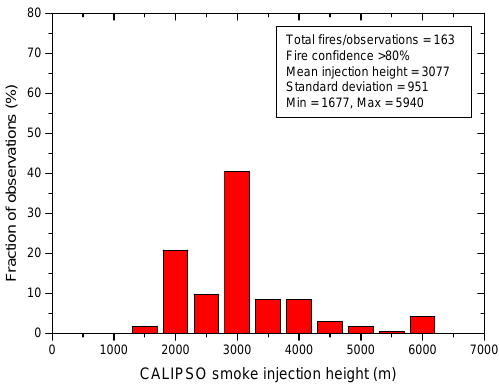
Fig. 4. Frequency distribution of the aerosol top height binned in 500m height intervals, as retrieved by CALIPSO over the Western Russian and Eastern Europe during July and August 2006, 2007, 2008.